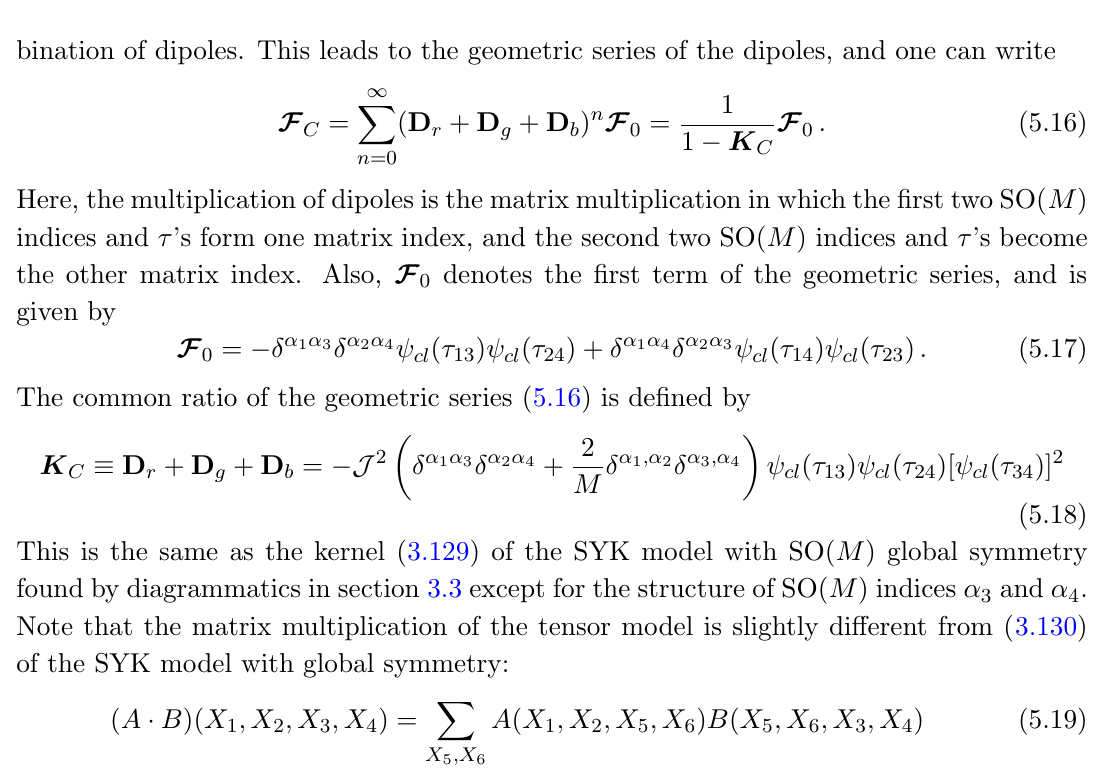
Figure 9. Schematic representation of O ( N ) contraction of the Cooper and Pillow four point functions. Each vertex represents a fermion, and the colored edge denotes the contraction of O ( N ) index of the corresponding color in the two